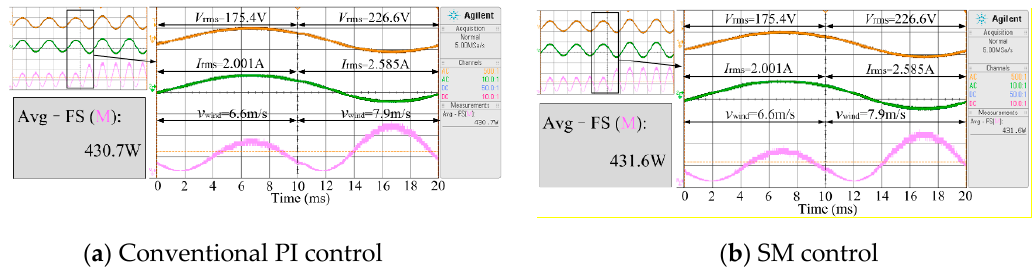
Figure 2. The experimental waveforms of the output voltage, the output current, and the output power of wind turbine system for wind speed altering from 6.6 to 7.9 m/s.